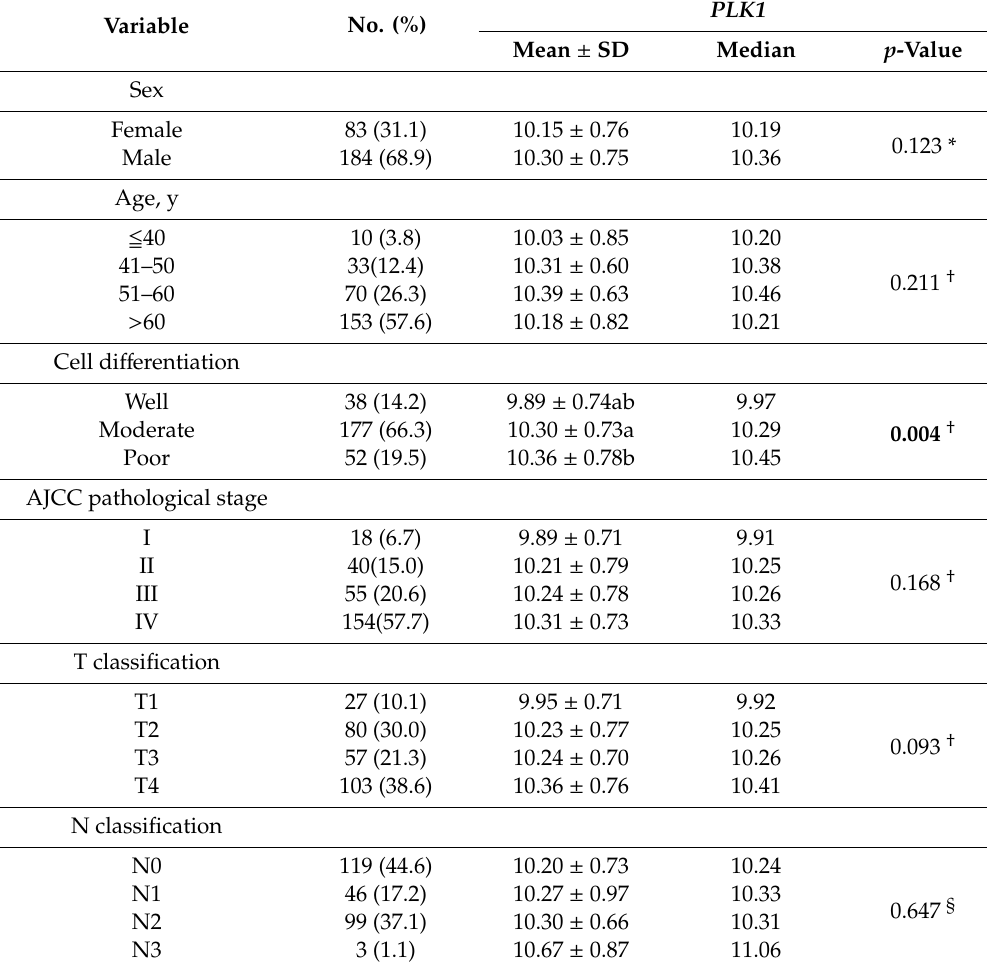
Table 1. Association of PLK1 expressions with clinicopathologic outcomes in patients with OSCC (oral squamous cell carcinoma).